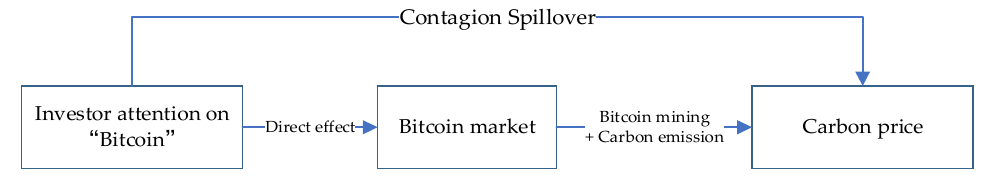
Figure 1. Cross market transmission mechanism.